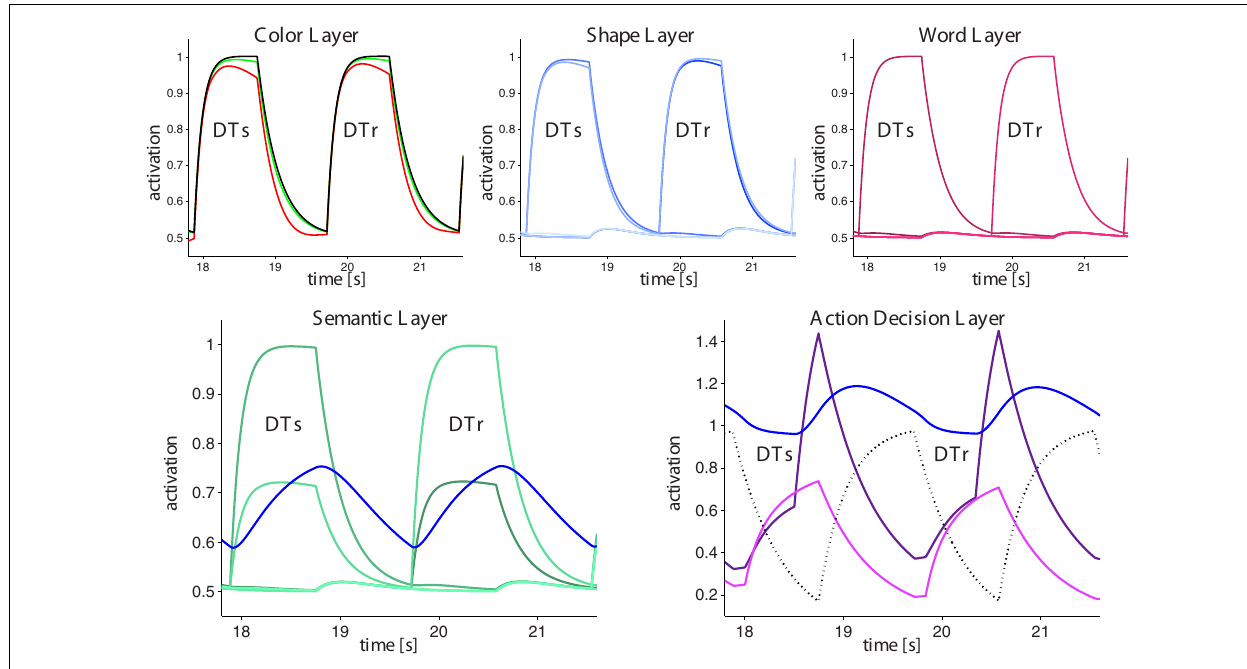
prime and probe trial).This plot illustrates the difficulty of comparing theories that are developed in a different context. Distractor inhibition theory itself is not able to explain a reaction time difference between the two conditions, as it is only formulated on a semantic level. Indeed GMNP does not show a difference in the traces except in the action layer, where persistent activation and relative inhibition causes the observed